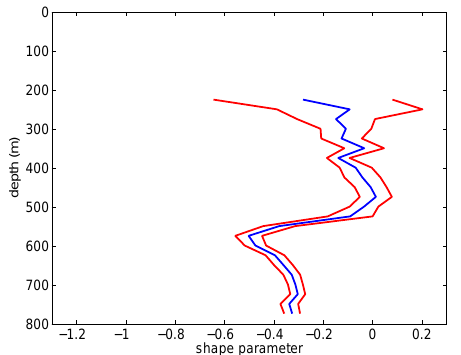
Fig. 6. Variation of the shape parameter (blue) and 95% confidence interval (red) with depth. The values of the shape parameter were obtained by fitting the GEV distribution to daily maxima of the sum of surge and mean residual flow at each available depth, at location FB.